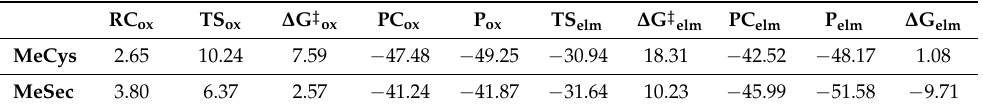
Table 5. Gibbs free energies (∆G, kcal/mol) relative to the free reactants for the oxidation and se- quential β-elimination of MeCys and MeSec in water. Activation and reaction Gibbs free energies are relative to RC ox for the oxidative step and to P ox for the elimination. Level of theory: COSMO- ZORA-BLYP-D3(BJ)/TZ2P. Data taken from [90].